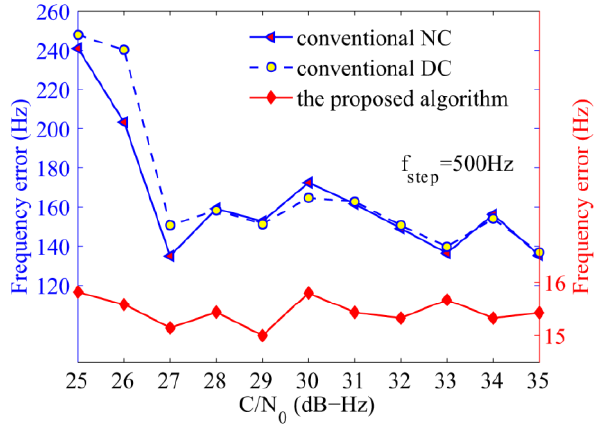
Figure 13. Average frequency errors of the NC, DC, and the proposed algorithms against C/N 0 .